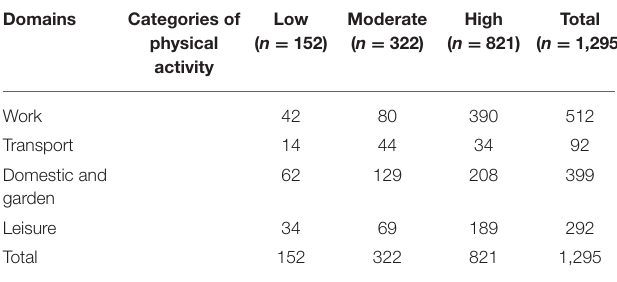
TABLE 3 | The relationship between the physical activity domains and the physical activity categories defined on basis of MET